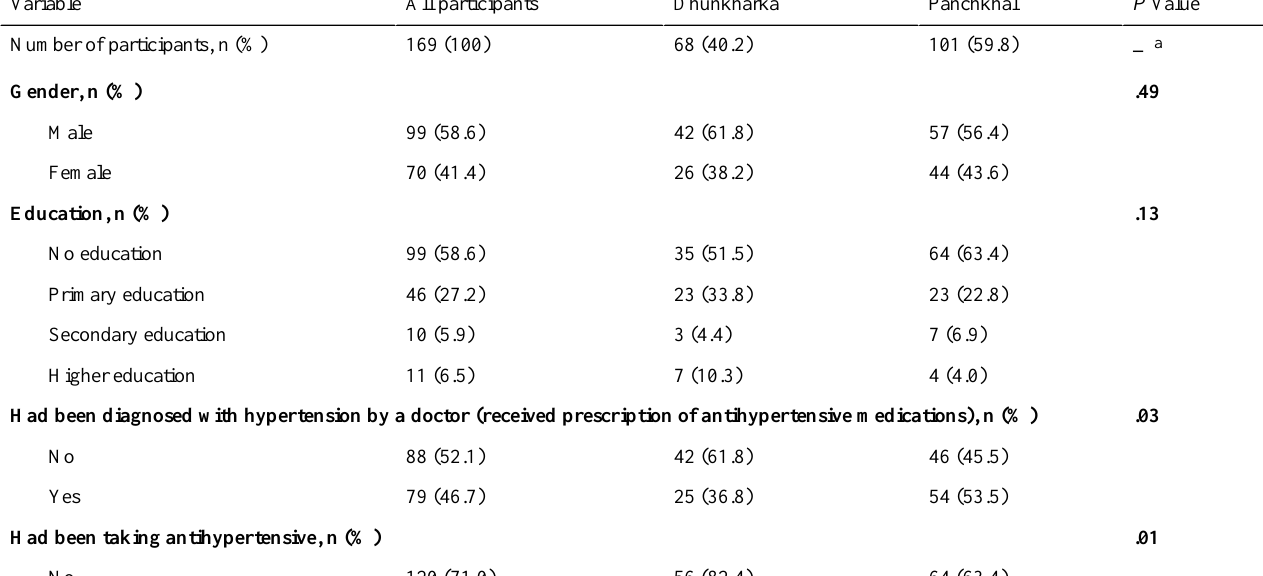
P ValuePanchkhalDhunkharkaAll